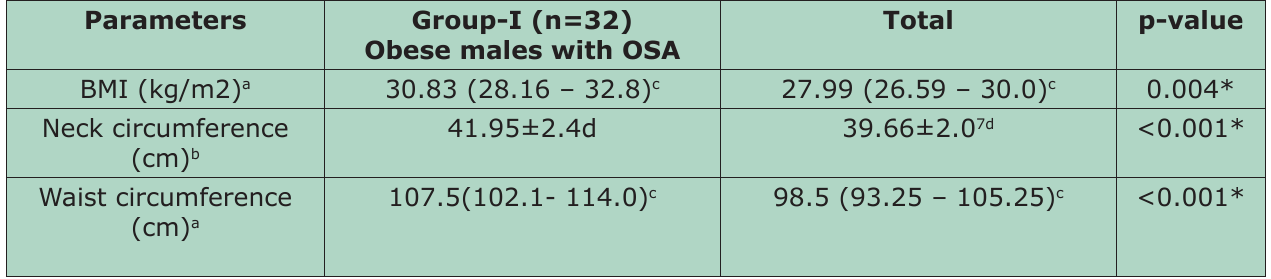
Table-I: Comparison of anthropometric parameters between group-I and II.